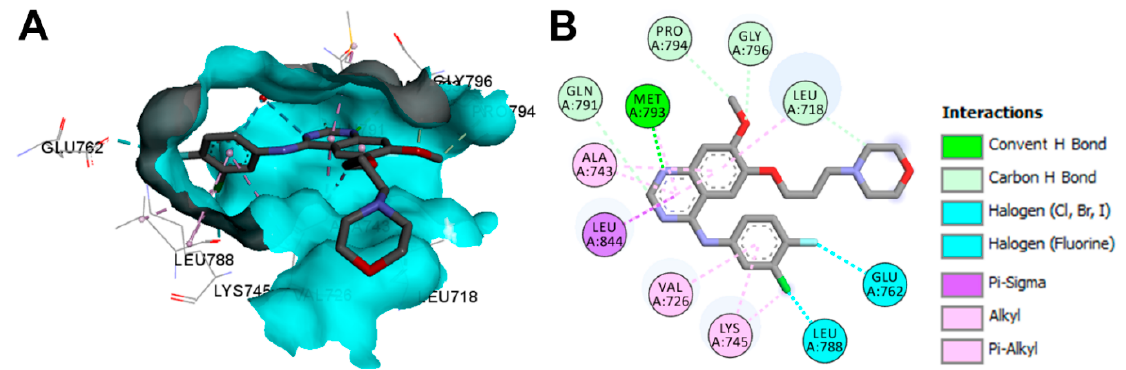
Figure 32. Binding modes of gefitinib (shown as sticks) into EGFR kinase domain (pdb: 2ITY): ( A ) 3D binding mode, receptor shown as hydrogen bond surface; ( B ) 2D binding mode showing different types of binding interactions; the figure was generated using Discovery Studio Visualizer (V16.1.0.15350).